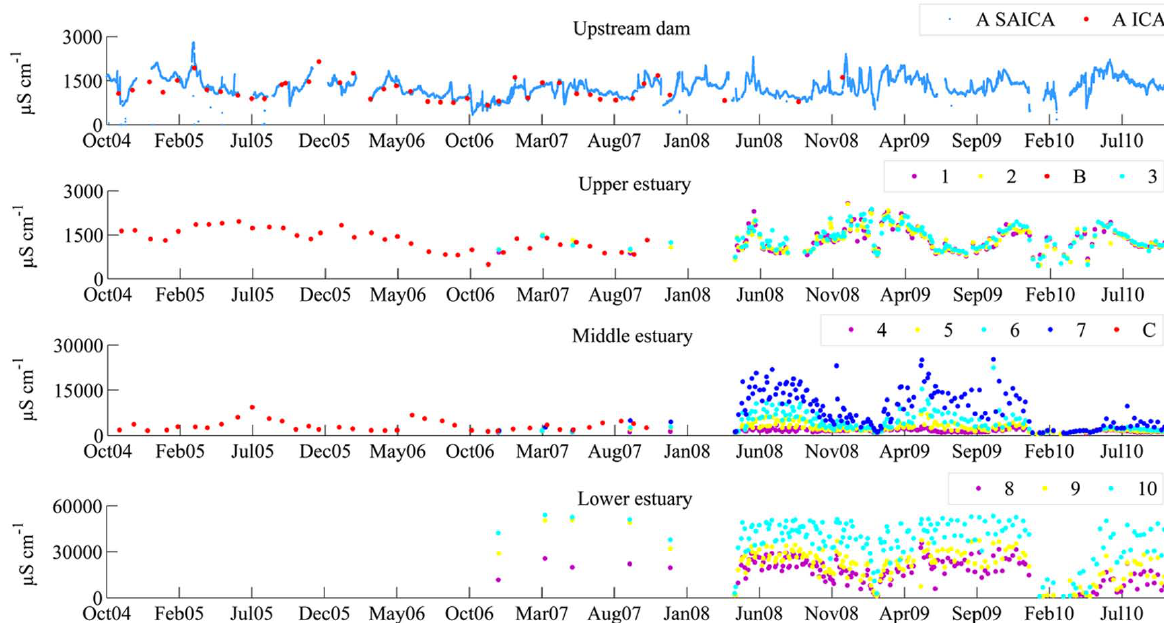
Fig. 4. EC in ICA, JA and SAICA stations throughout the estuary, period October 2004–July